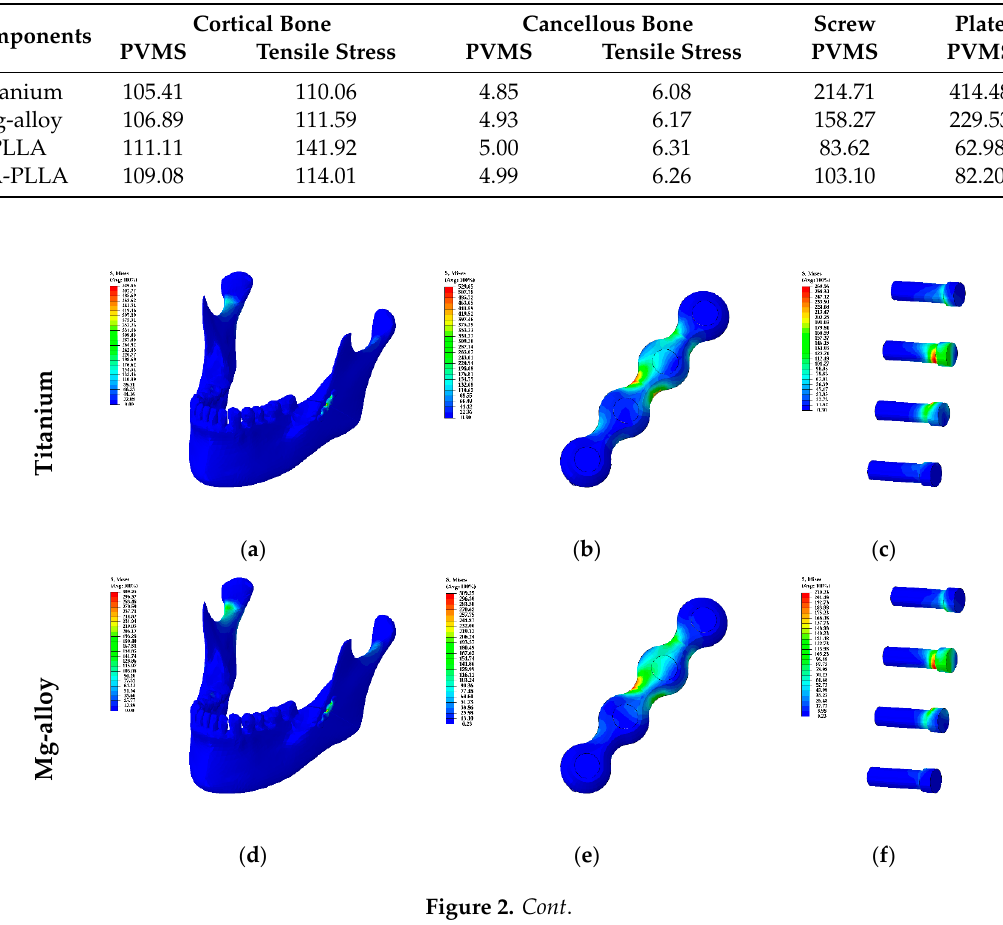
( l ) Figure 2. Visualization of Table 2: the distribution of stress in plate and screw systems based on materials is demonstrated from ( a ) to ( l ). The left column presents the stress on the mandible and the fixations while the middle column presents the stress of fixations: mini ‐ plates and screws. The right column presents the stress on the screws solely. 3.5. Deformation of the Materials in Masticatory Loading